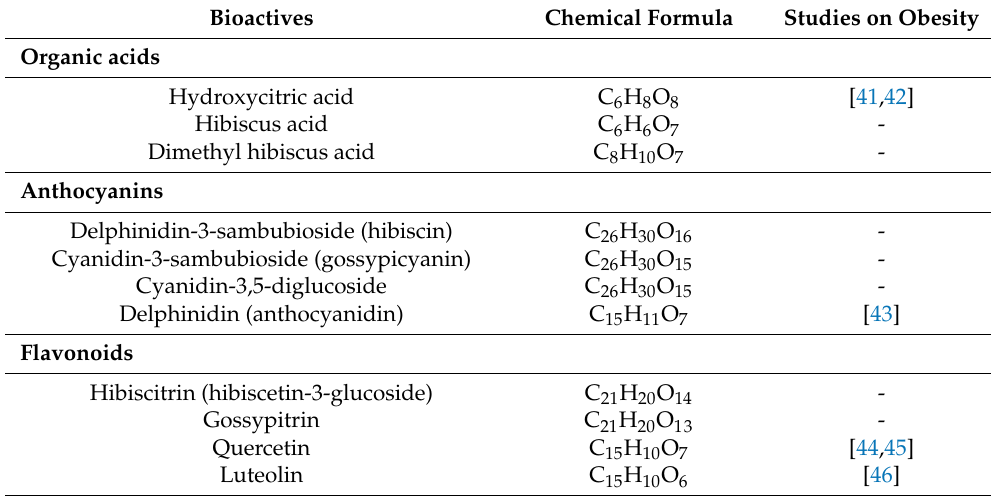
Table 1. Major bioactive compound in H. sabdariffa